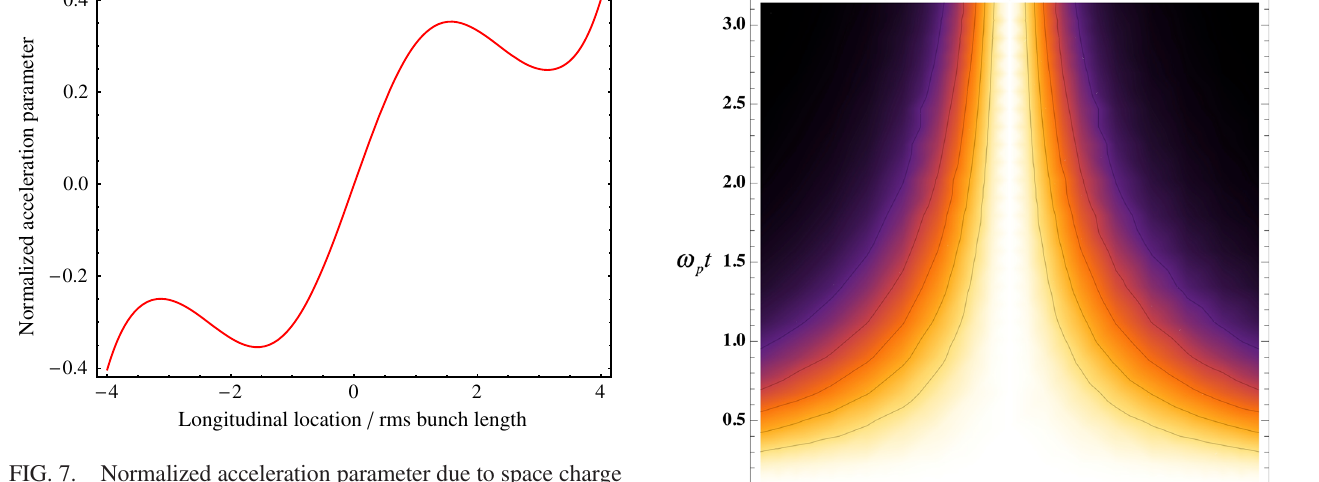
FIG. 7. Normalized acceleration parameter due to space charge field (for the CeC PoP parameters listed in Table 1) as function of the longitudinal coordinate within a bunch.